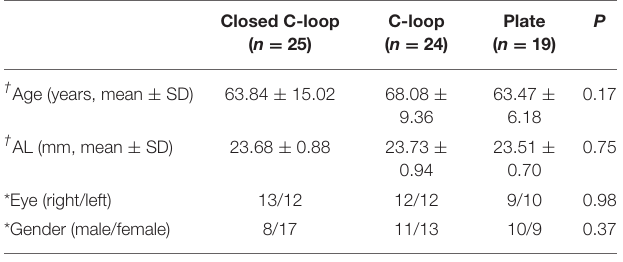
TABLE 2 | Demographics of study subjects implanted with different haptic design of intraocular lenses.